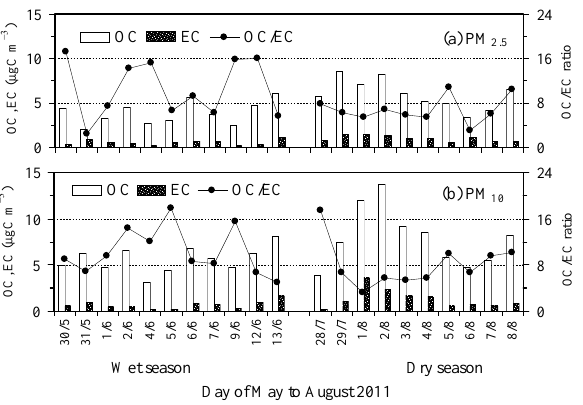
Fig. 3. Temporal variations in the concentrations of OC and EC and OC/EC ratios at the Morogoro site during the wet and dry seasons in (a) PM 2 . 5 and (b) PM 10 .